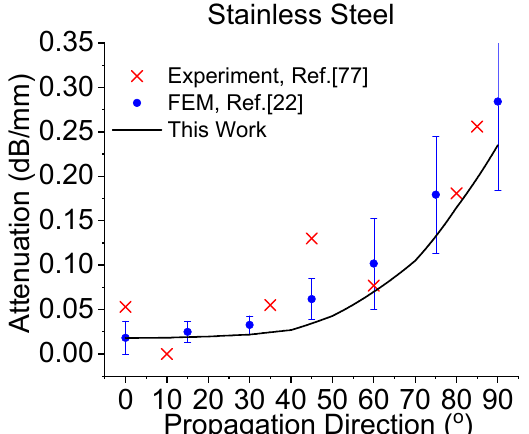
Figure 4. Attenuation comparison of the second-order attenuation (SOA) model (this work) to available experimental results (from Ref. [77]) and finite element modeling (FEM) results (from Ref. [22]) on a textured 316L stainless steel polycrystal with mean grain sizes a x = a y = 0.125 mm, a z = 2.5 mm. The error bars of the FEM results are also from Ref. [22].